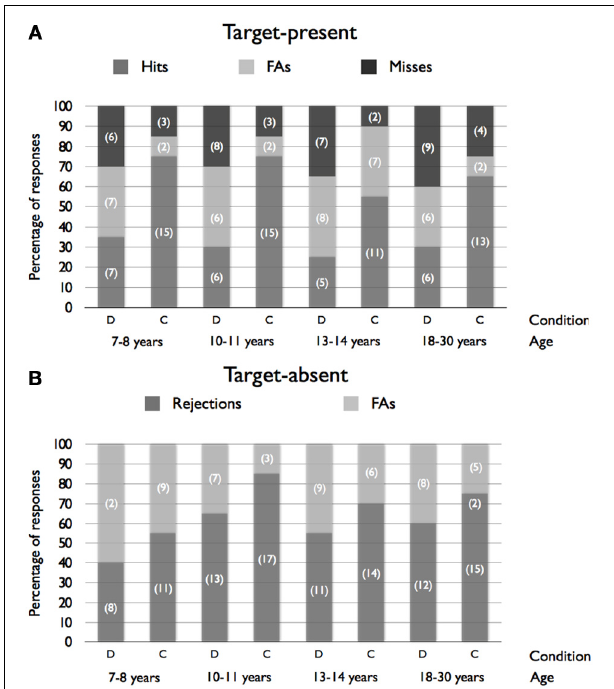
FIGURE 2 | Percentages of hits, false alarms (FAs), miss responses and rejections as a function of Age and Condition for target-present (A) and target-absent (B) conditions (frequencies are presented in brackets). Note that a correct response was represented by the identification of the target in the “target-present” lineup but choosing no one in the “target-absent”